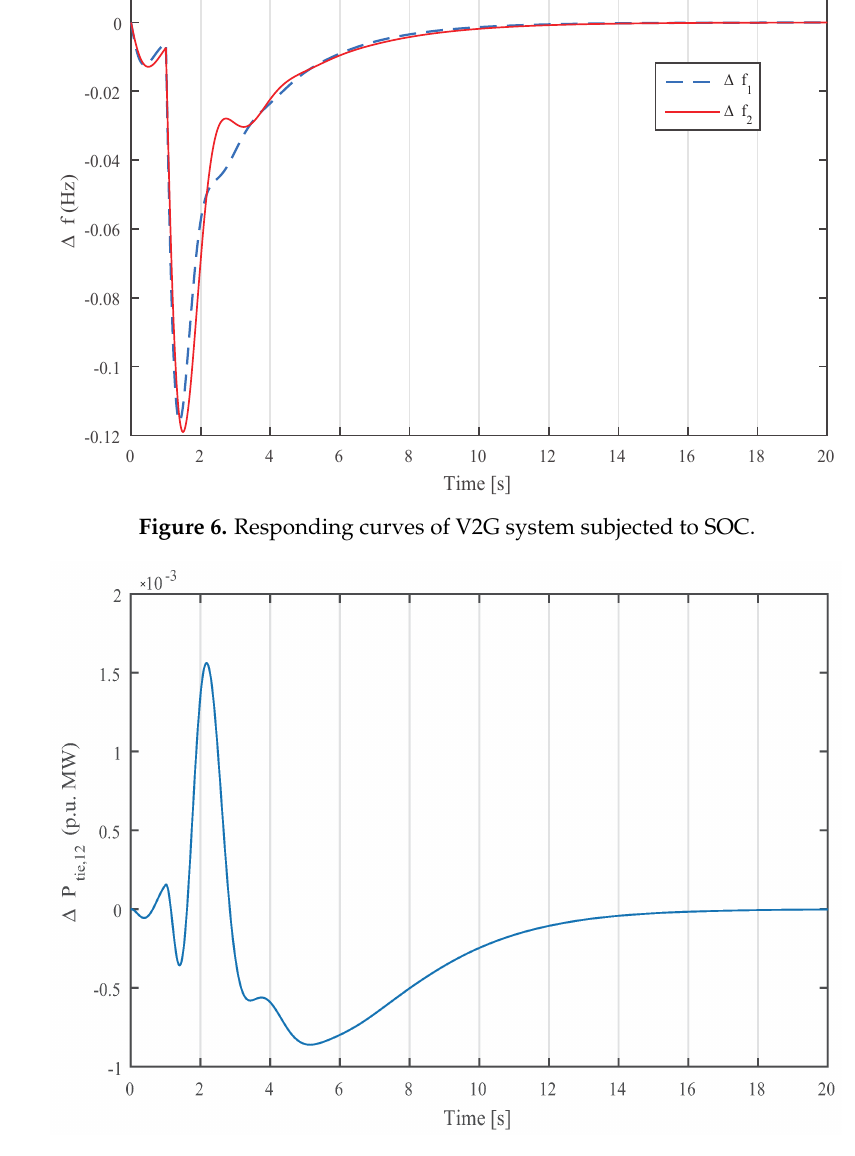
Figure 7. Power flow of V2G system subjected to